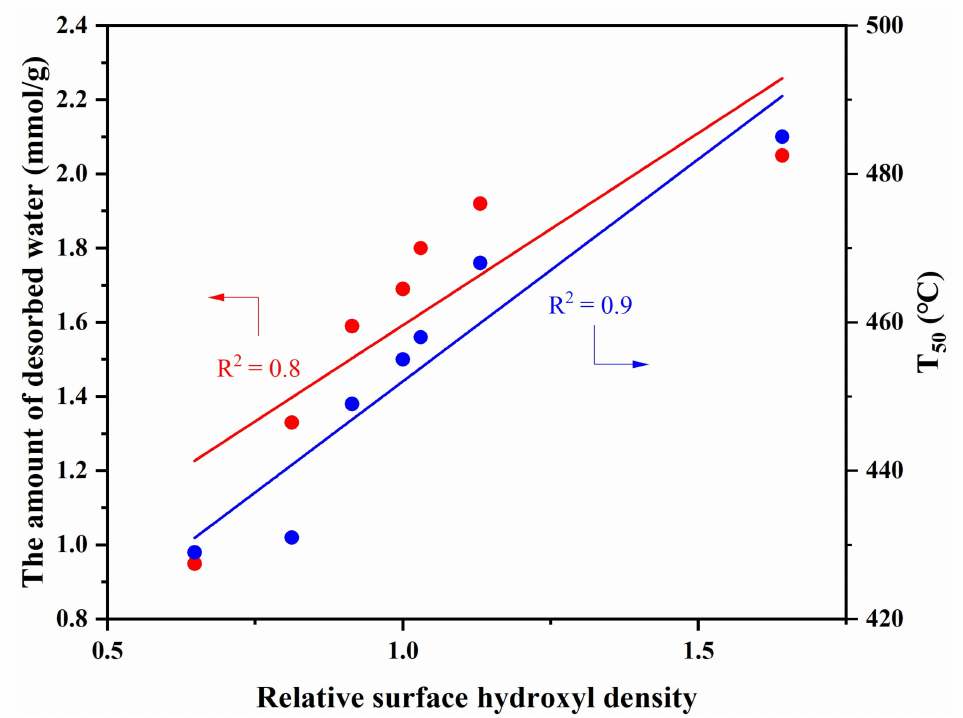
Figure 10. Plot of relative surface hydroxyl density with hydrophobicity (the amount of desorbed water) and methane oxidation activity (T 50 tested in the presence of 8%